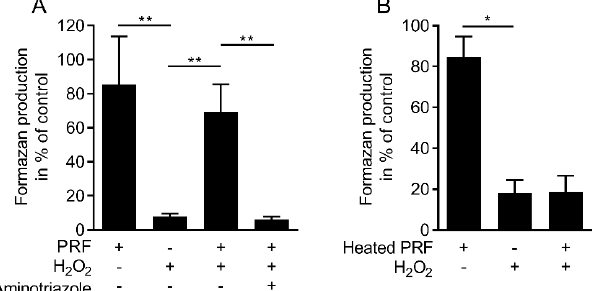
Figure 4. Blocking catalase attenuates the activity of PRF lysate in preventing cell death. Gingival